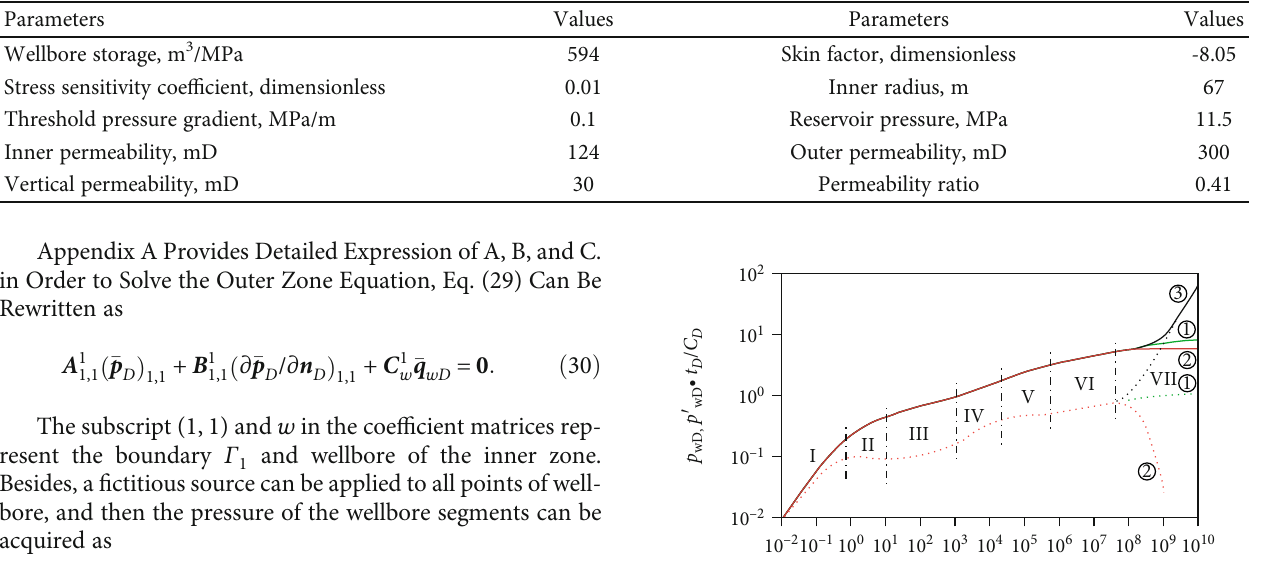
Table 1: Interpretation results of fi eld test data.